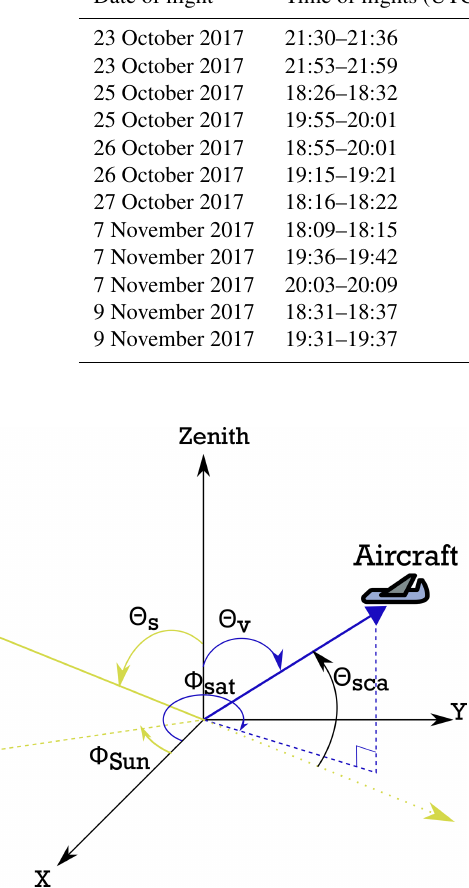
Figure 2. AirHARP viewing geometry and definition of angles. (cid:50) s is the solar zenith angle, (cid:50) v is the viewing zenith angle, (cid:56) sun is the solar azimuthal angle, (cid:56) sat is the viewing azimuthal angle, and (cid:50) sca is the scattering angle. The point where X and Y coordinates meet is the local ground